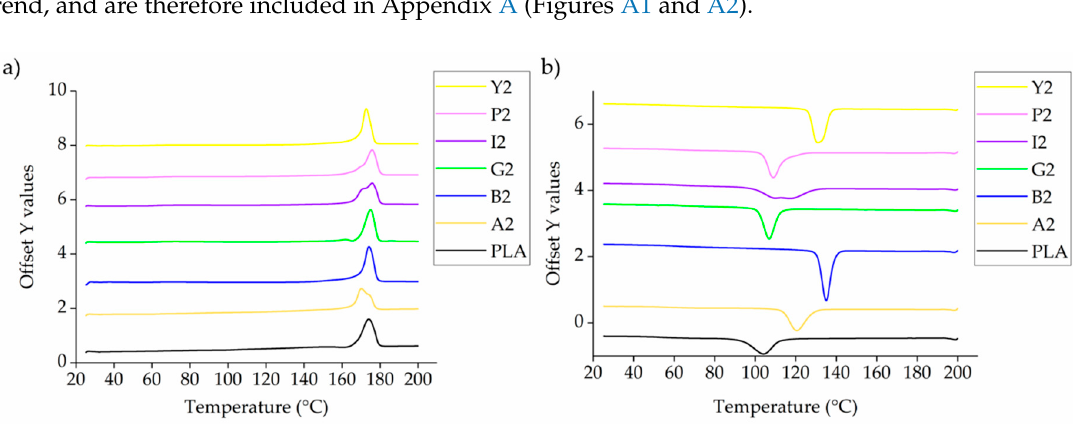
Figure 4. DSC thermograms of PLA and composites containing 2% (w/w) of each additive during ( a ) the heating phase and ( b ) the cooling phase.